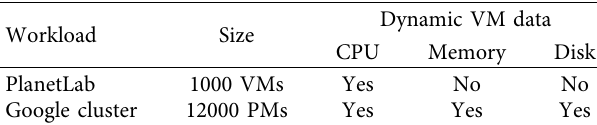
Table 1: Different real workload traces with